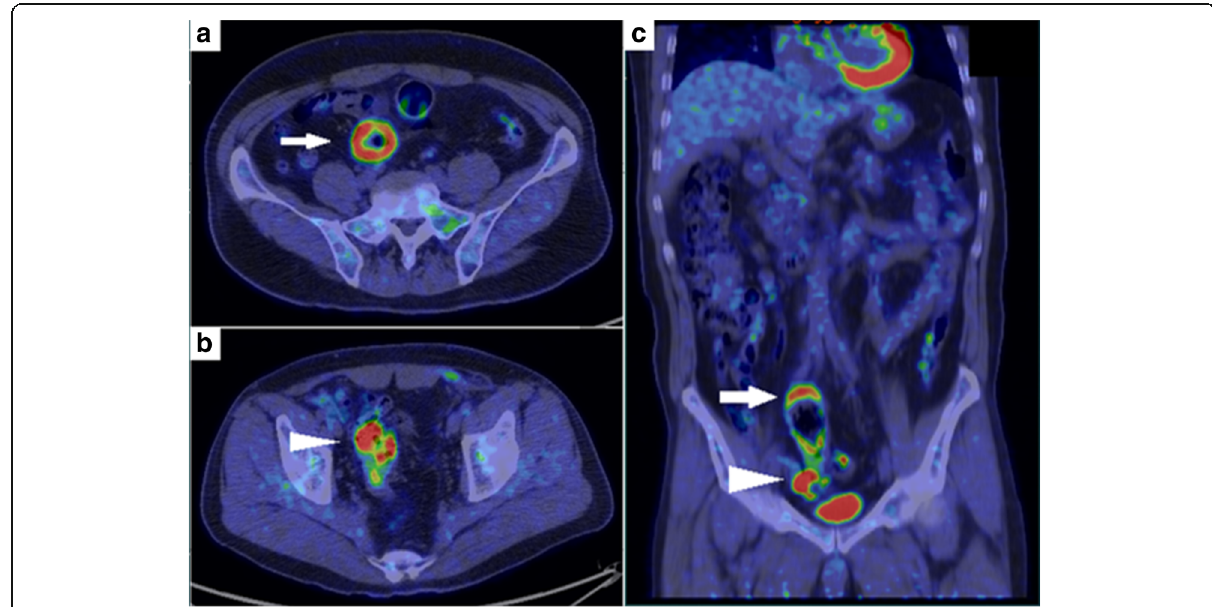
Fig. 3 Positron emission tomography-computed tomography revealed two lesions in the sigmoid colon with increased maximal standardized uptake values (SUV max ) (arrow). a axial view: the proximal circumferential lesion (arrow) with SUV max = 10.7, b axial view: the distal lesion (arrowhead) with SUV max = 11.2, and c coronal view: both lesions located in the sigmoid colon